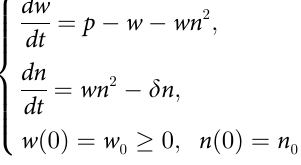
Fig 1. A model for the surface runoff on a slope. The term v @ w describes the drop of runoff in vegetated areas due to increased infiltration. Arrows indicate the direction of motion for surface water.